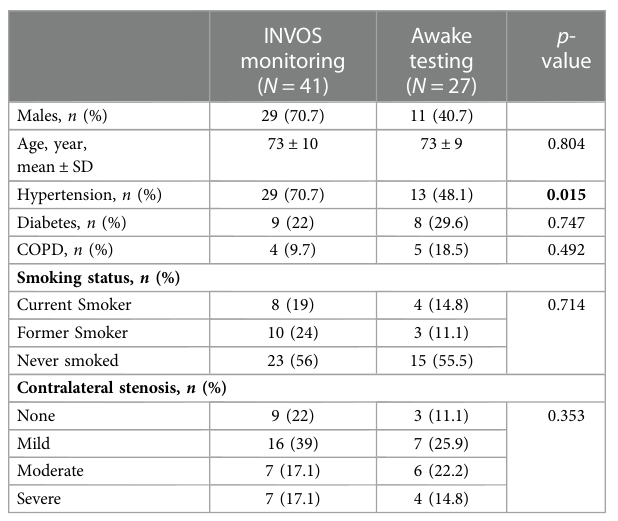
TABLE 1 Baseline characteristics in INVOS monitoring versus awake testing groups.